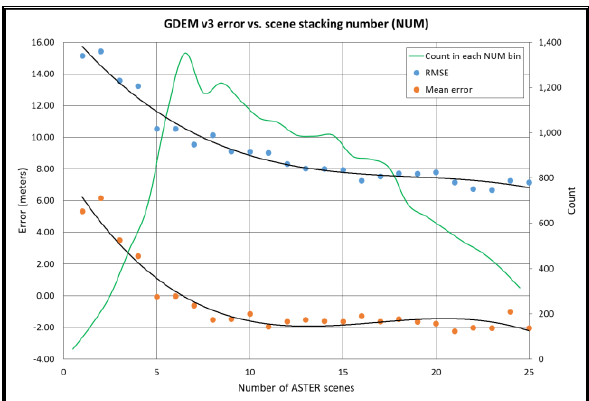
Figure 5. GDEM v3 mean error and RMSE vs. number of scenes used for elevation calculation.